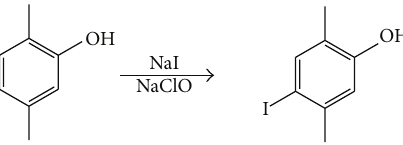
Scheme 2: Synthesis of